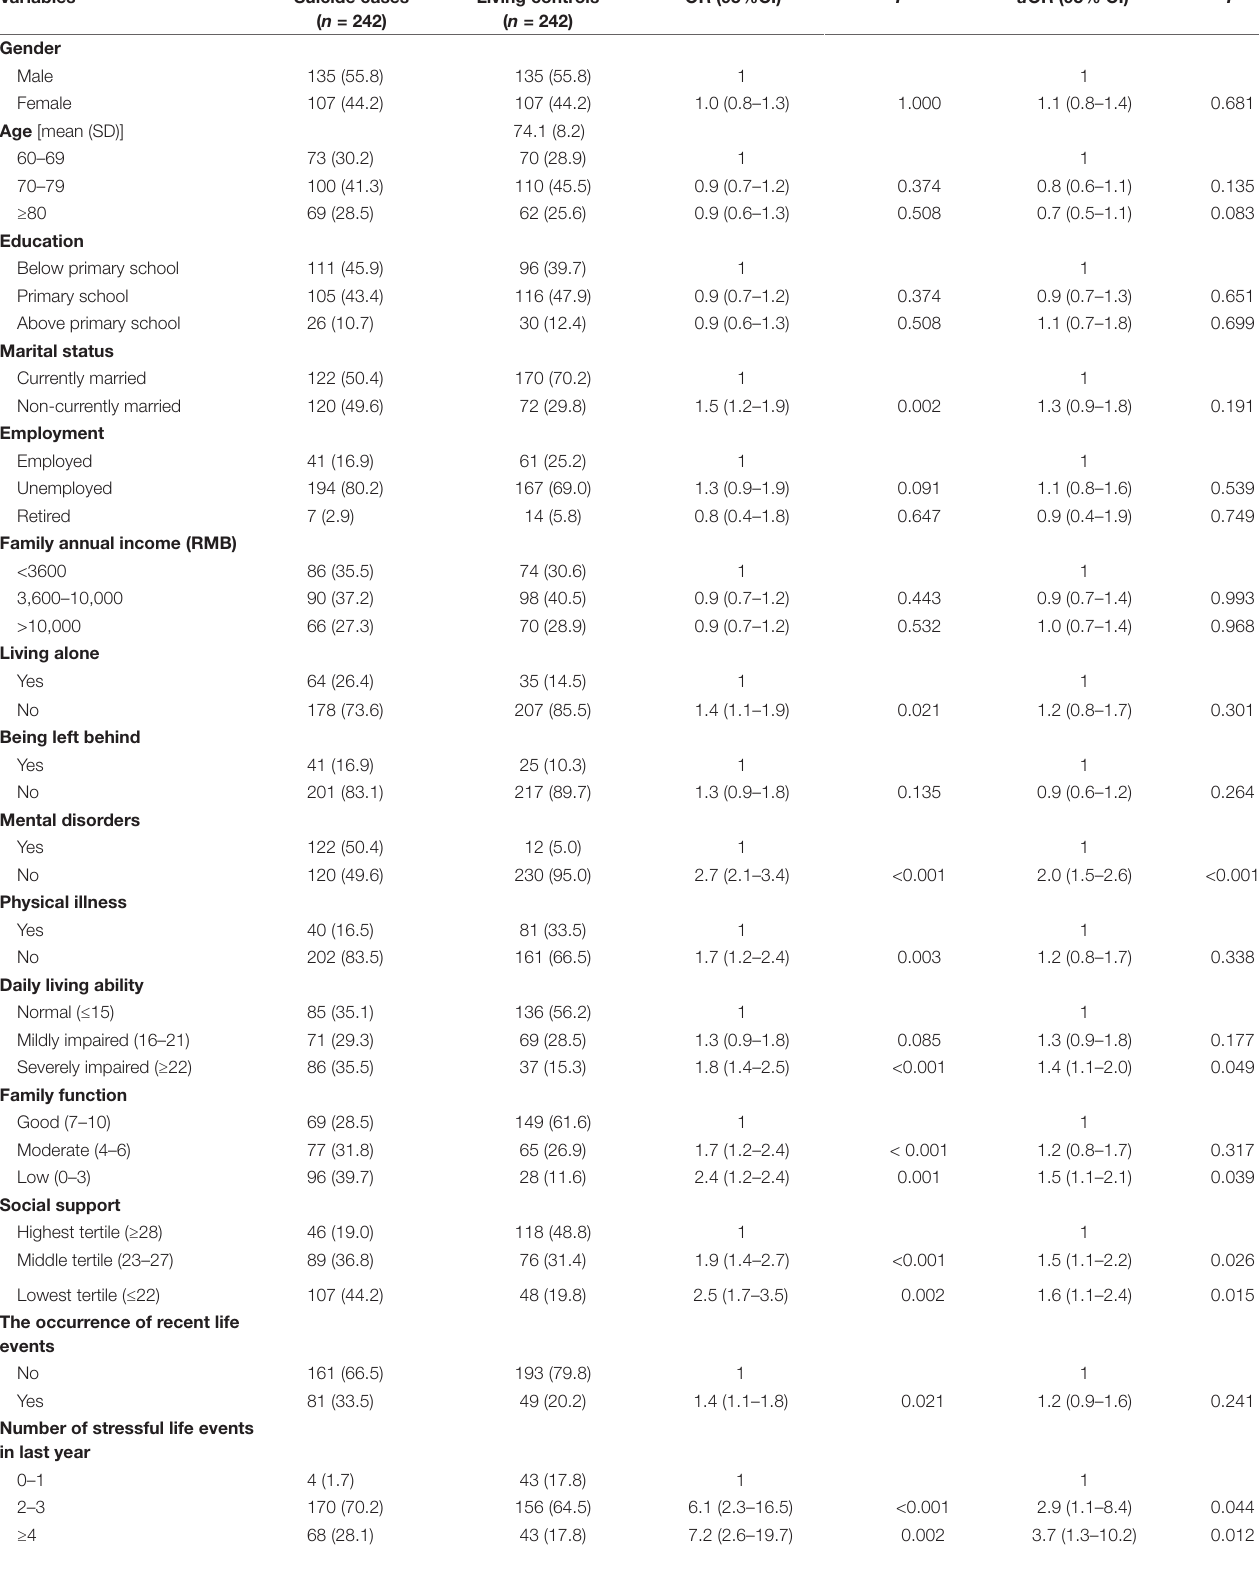
TABLe 1 | Characteristics of suicide cases and living